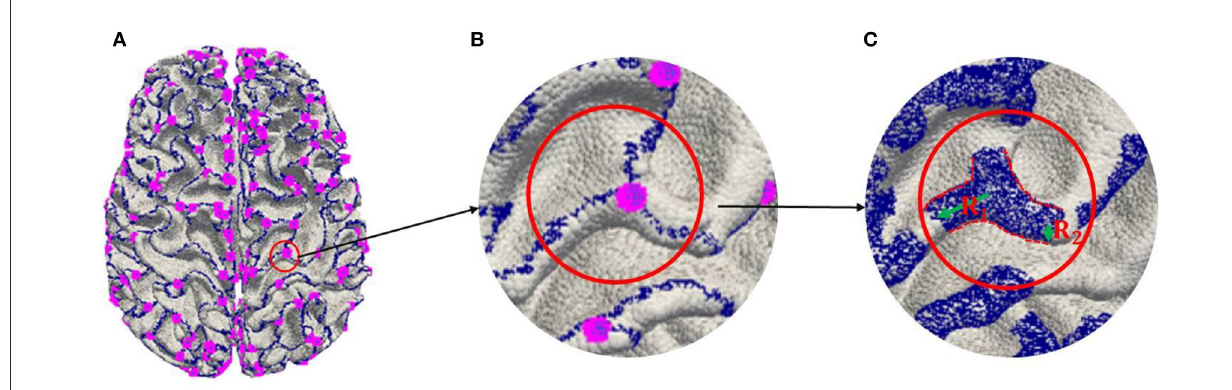
FIGURE3 Labeling 3-Hinges regions. (A) Extracting 2-Hinges and 3-Hinges vertices by Gyral-net algorithm. (B) Zoom in 3-Hinges. (C) Expanding 2-Hinges and 3-Hinges regions.